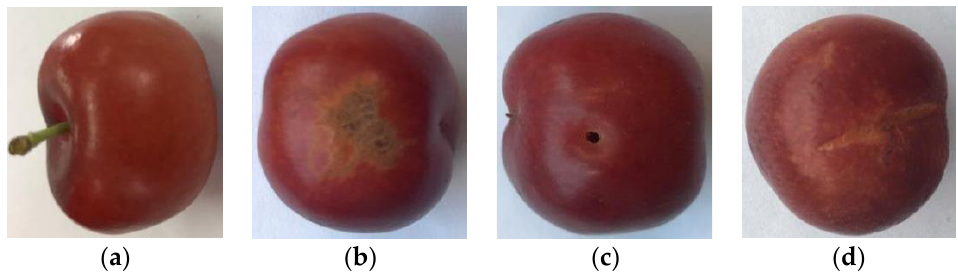
Figure 1. The intact and defective samples of Cerasus humilis fruits: ( a ) Intact sample; ( b ) Rust spot sample; ( c ) Insect damage sample; ( d ) Crack sample.